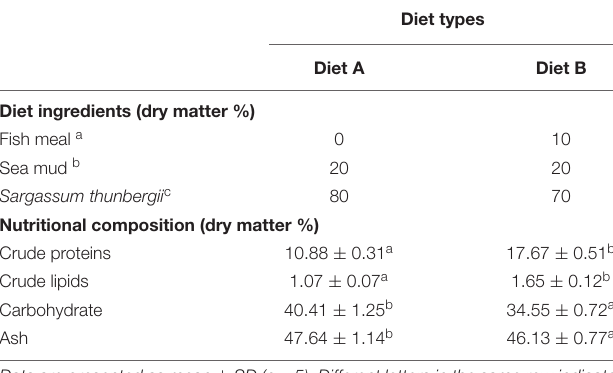
TABLE 1 | Ingredients and nutritional composition of experimental diets fed to A. japonicus .